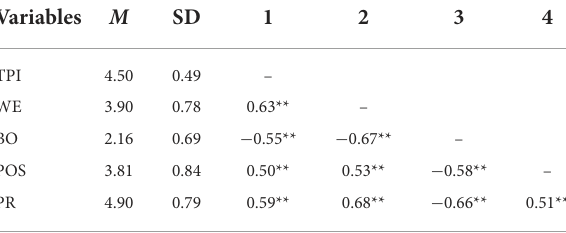
TABLE 1 Means, standard deviations, and bivariate correlations among